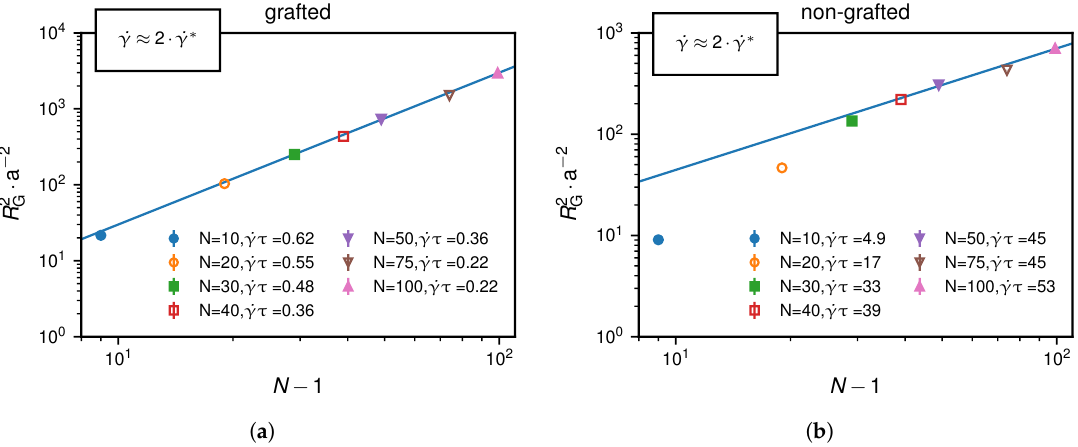
Figure 6. Squared radius of gyration slightly above the critical shear rate at ˙ γ ≈ 2 ˙ γ ∗ : The course of R 2 as a function of N − 1 suggests for ( a ) the grafted scenario that the chain is fully stretched, R 2 and ( b ) the non-grafted scenario that the chain is swollen, R 2 blue lines are given in Equation